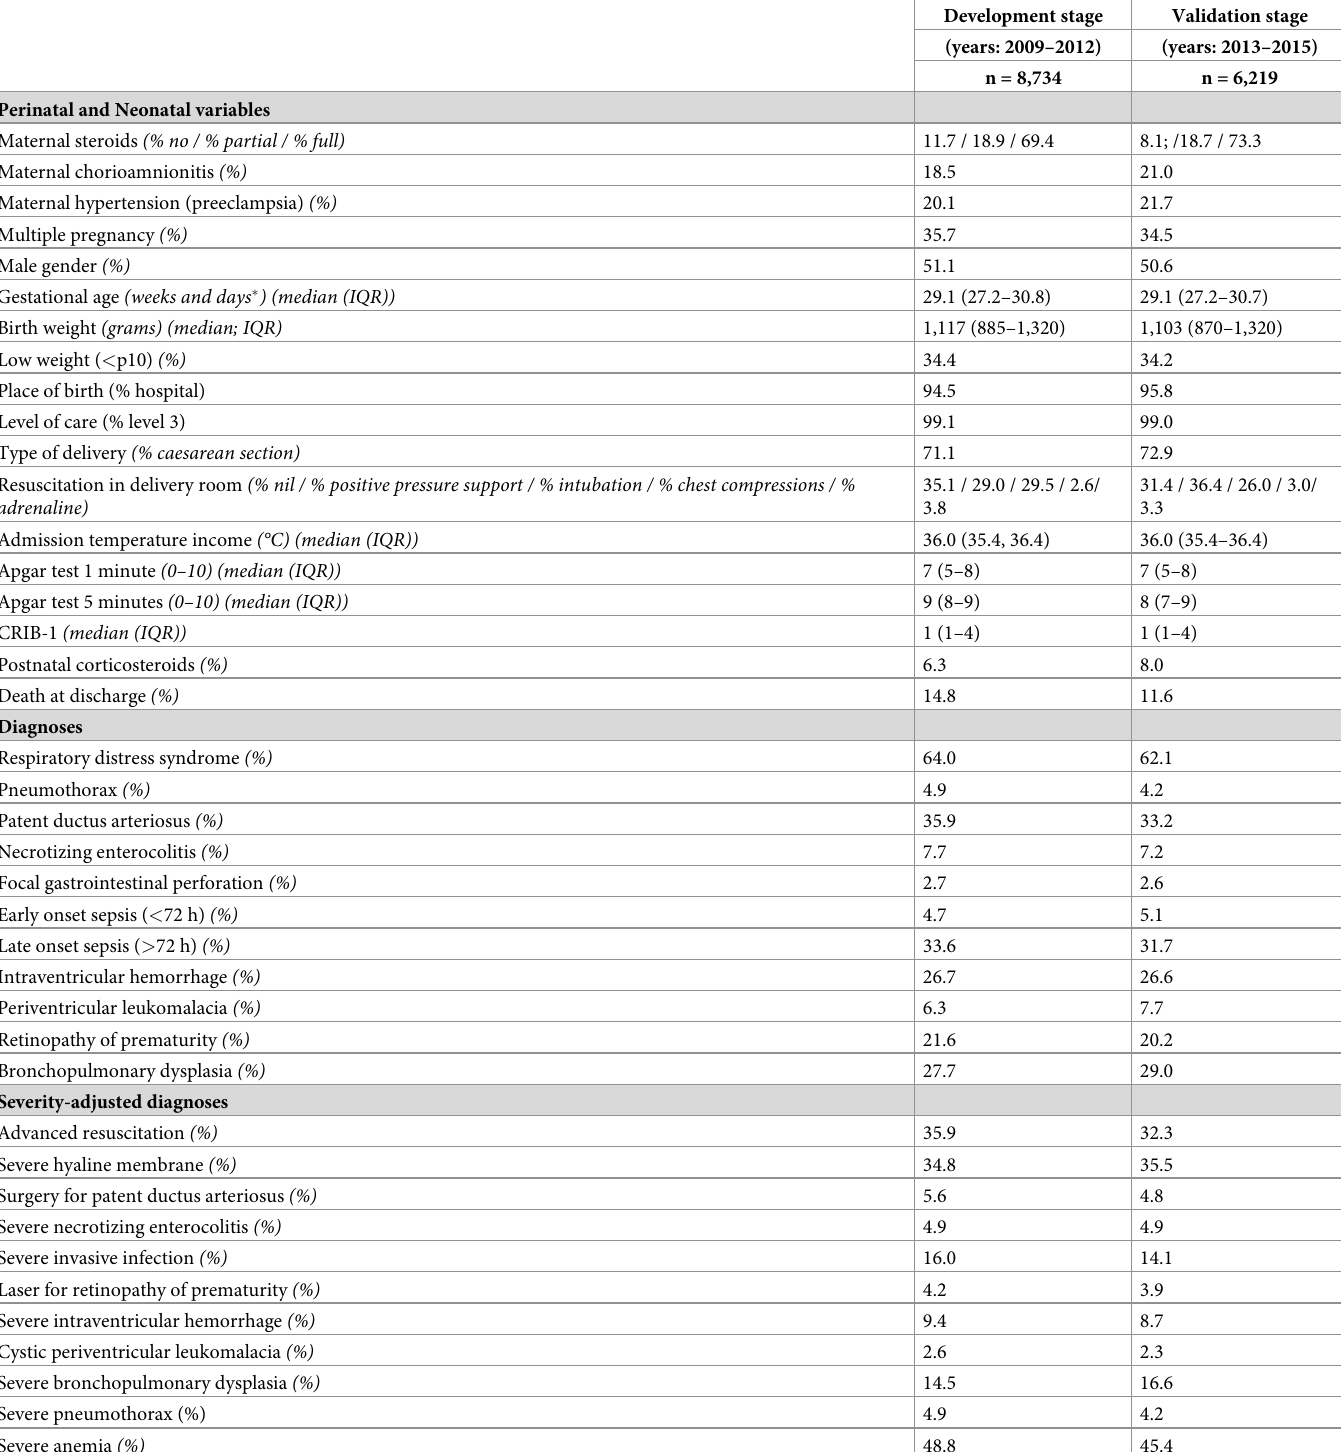
Table 2. Perinatal and neonatal variables, diagnoses, and diagnoses adapted according to severity criteria in the patients